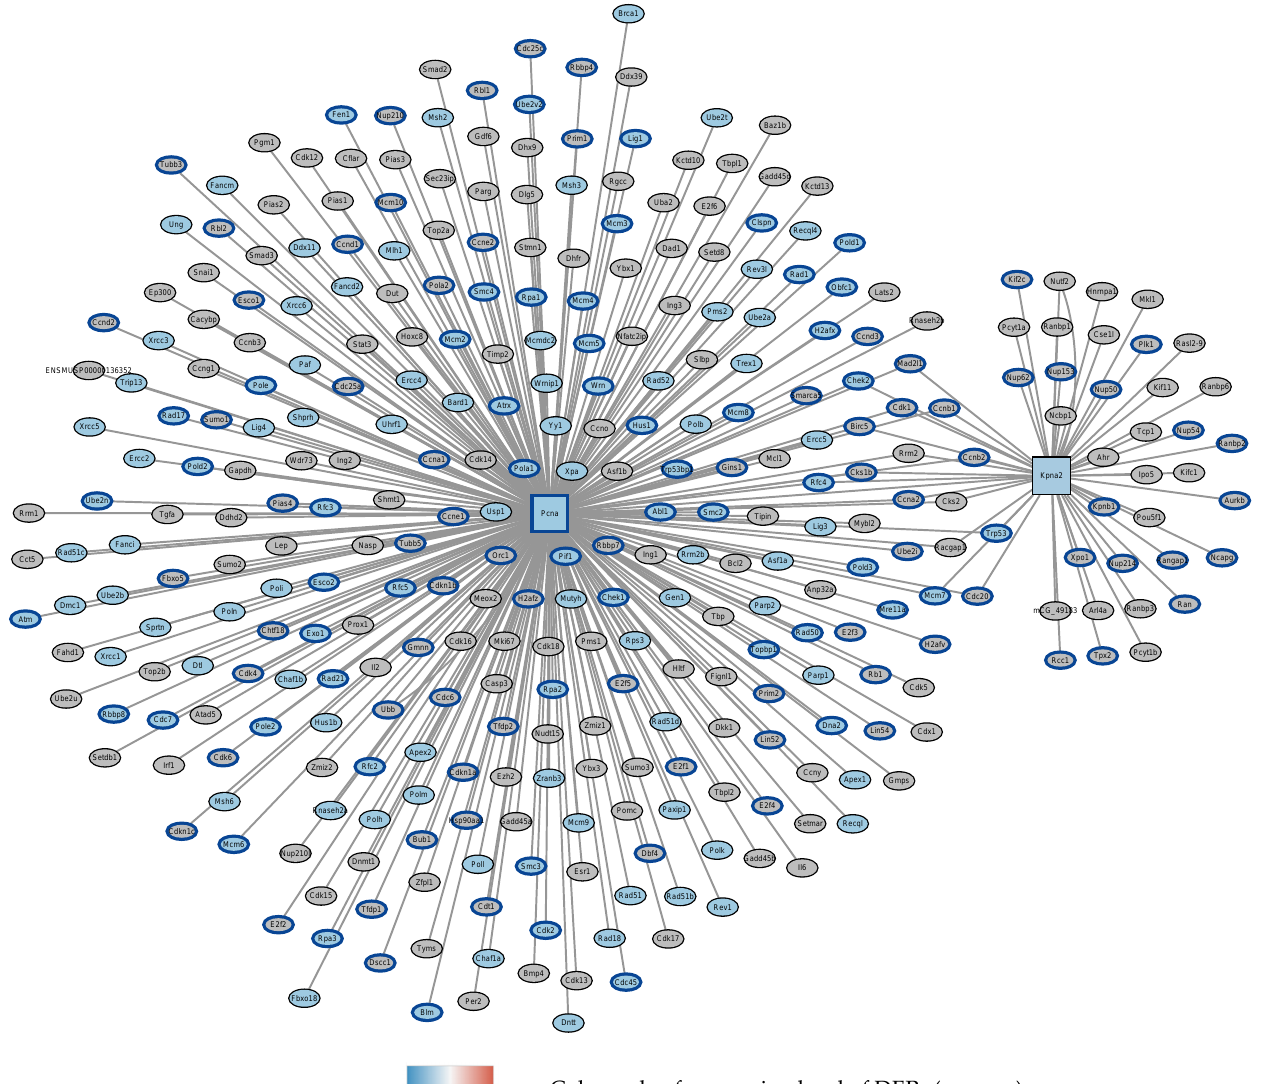
Color code of expression level of DEPs (squares) −2.85 +2.85 Figure 4. Subnetwork 1 of functionally associated DEPs and their interaction partners after 72 h exposure to 0–95% O 2 . Squares: seed proteins; ellipses: interaction partners. Colors of the ellipses highlight the following enriched pathways with FDR < 0.05: Downregulated: DNA repair (blue fill color) (GO database), cell cycle (blue border) (Reactome data